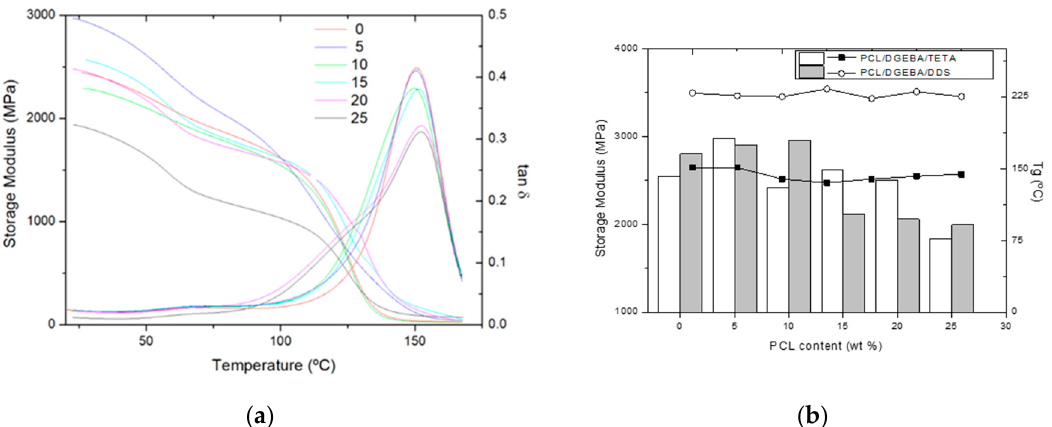
Figure 5. Dynamic mechanical thermal analysis (DMTA) curves of PCL/DGEBA/TETA blends ( a ) and DMTA results of PCL/epoxy blends ( b ): storage modulus in glassy state at 30 °C (bars in left axis) and α -relaxation temperature (dots in right axis).